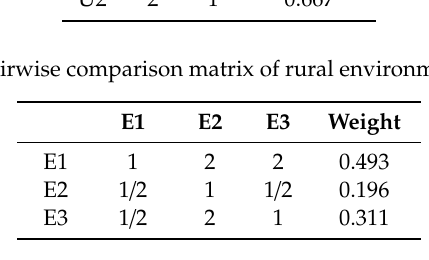
Table A13. Urban and rural water poverty values in northwest China from 2000 to 2017. U /